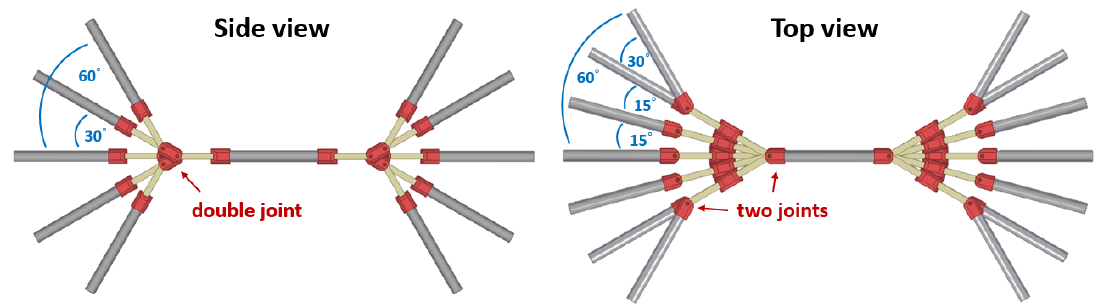
Figure 21. Range of motion of the device from the side and top views.